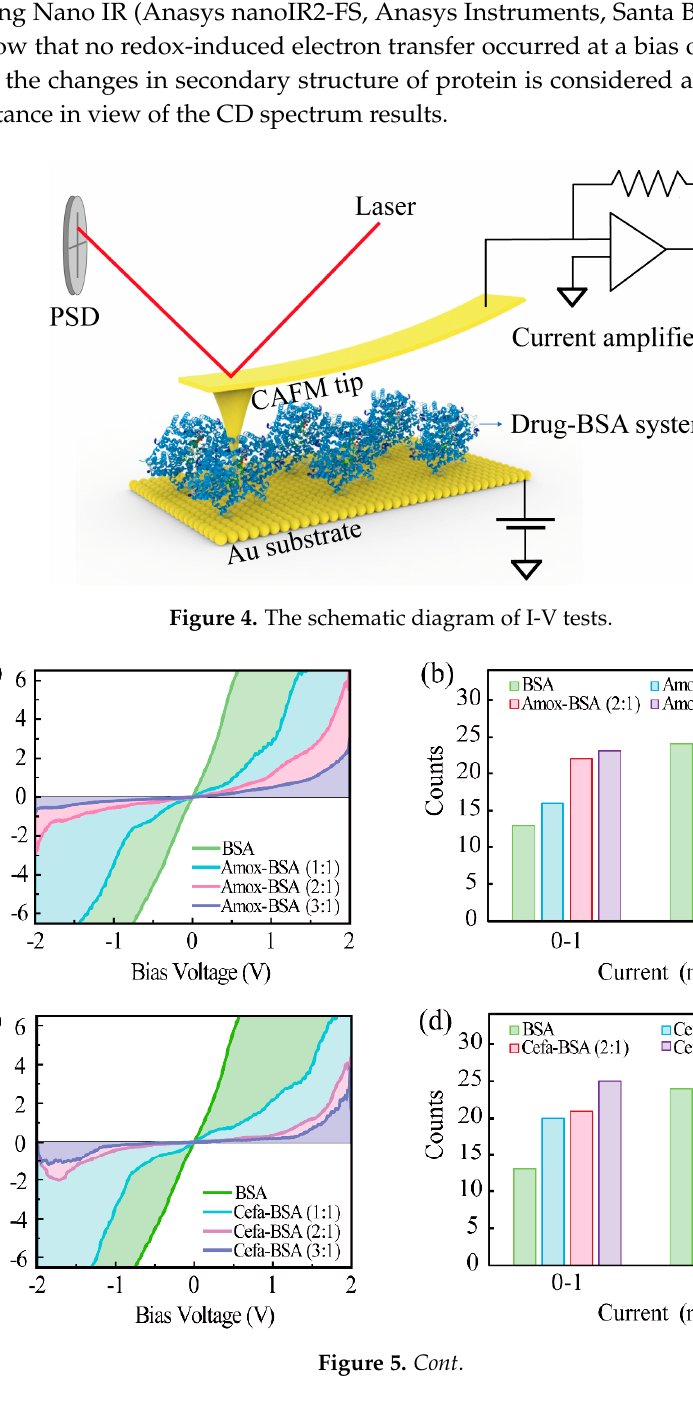
Figure 5. The I-V characteristics of BSA and Amox-BSA system ( a ), Cefa-BSA system ( c ), and Azit- BSA system ( e ). At + 2.0 V, the number of curves with currents falling within the ranges 0–1 nA and